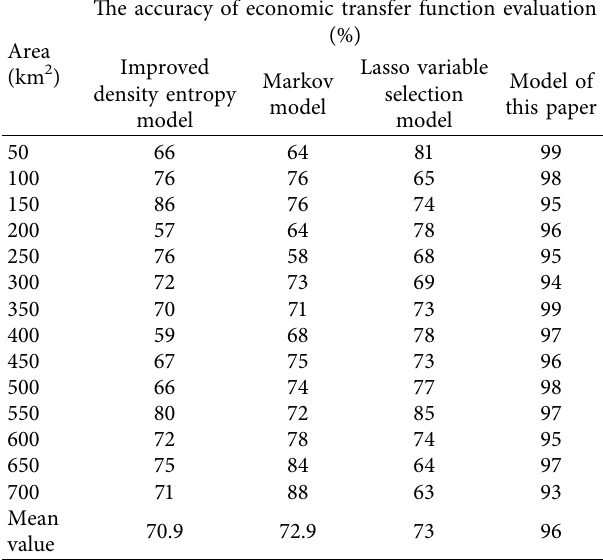
Table 2: Evaluation accuracy of population economic transfer function under different